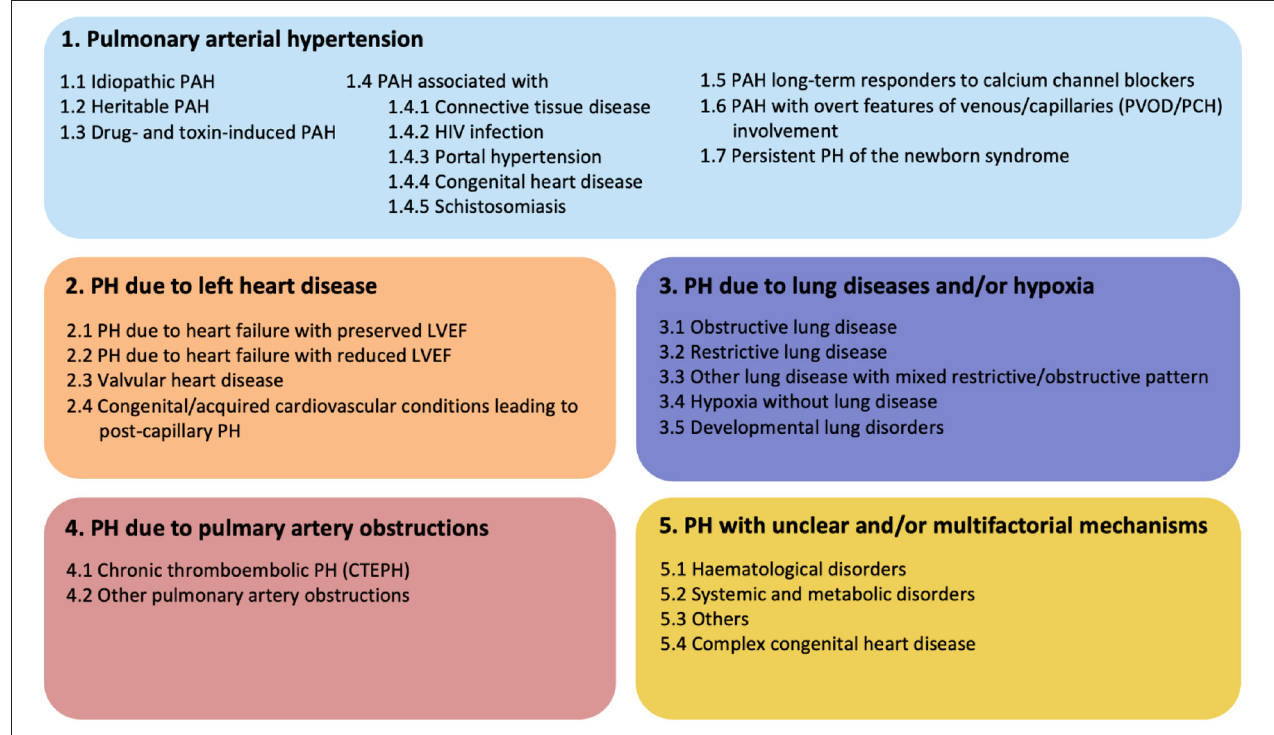
FIGURE 1 | Updated clinical classification of pulmonary hypertension according to the 6th PH world symposium of 2018, Nice, France (1).